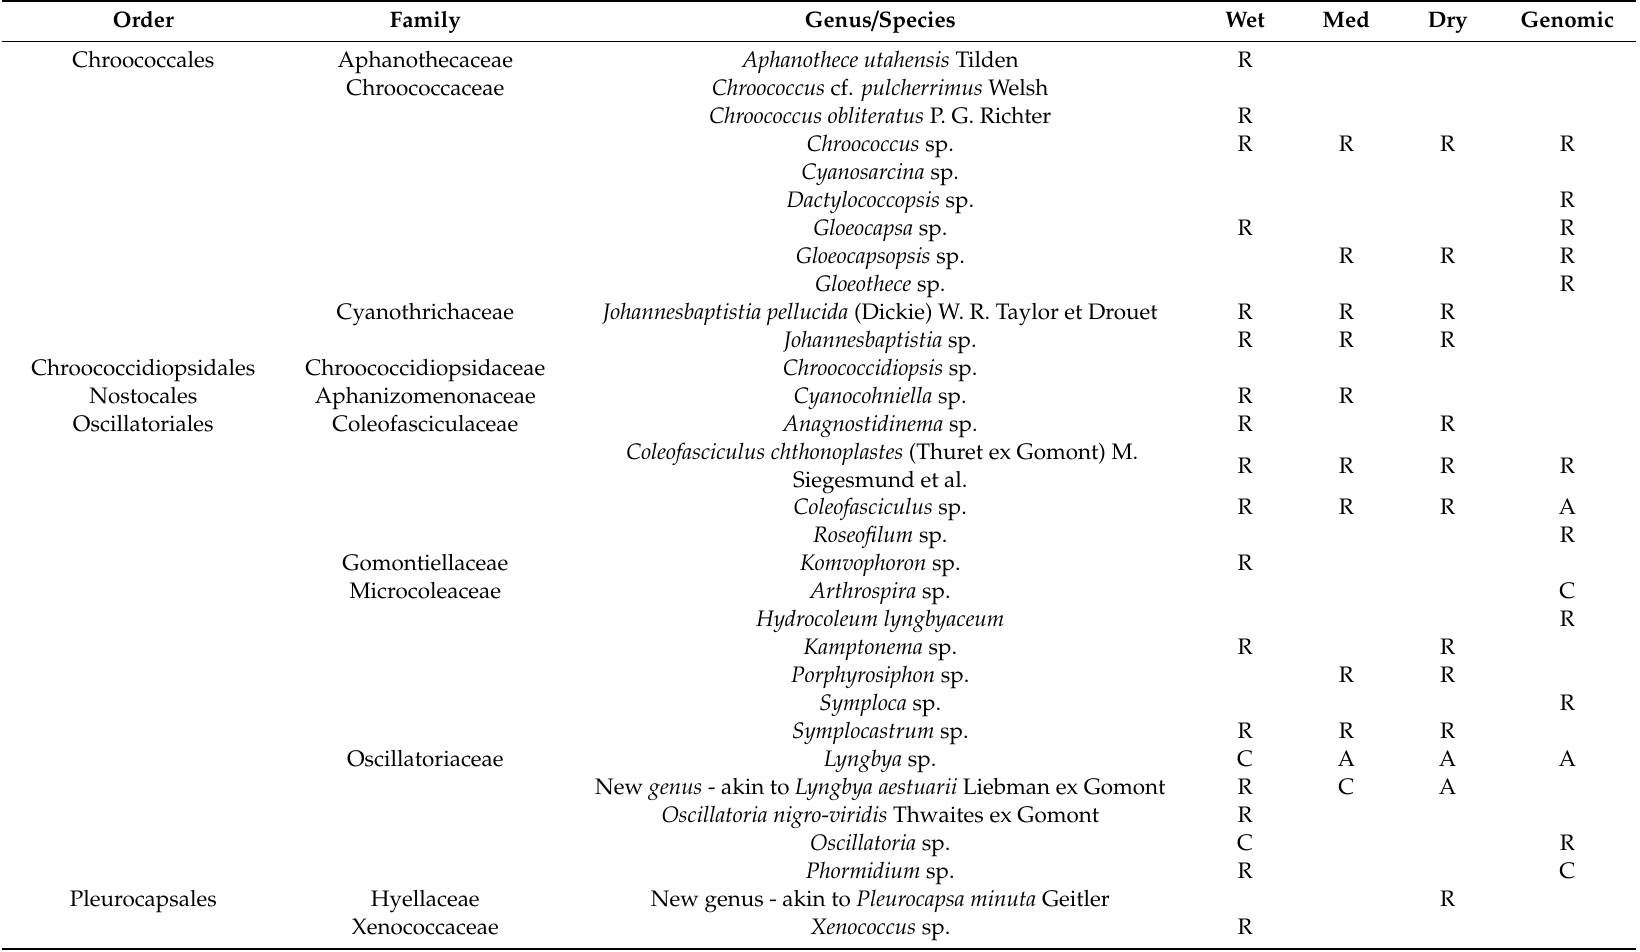
Table 2. List of the cyanobacterial species found in the sand flat mats in Laguna Madre. Med-medium; R-rare; C-common;